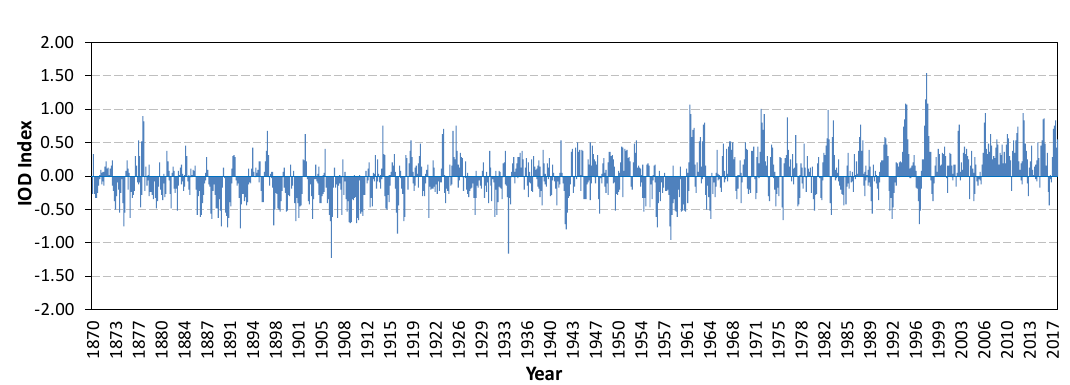
Figure 8. The monthly Indian Ocean dipole (IOD) index values for the period 1870 − 2017.